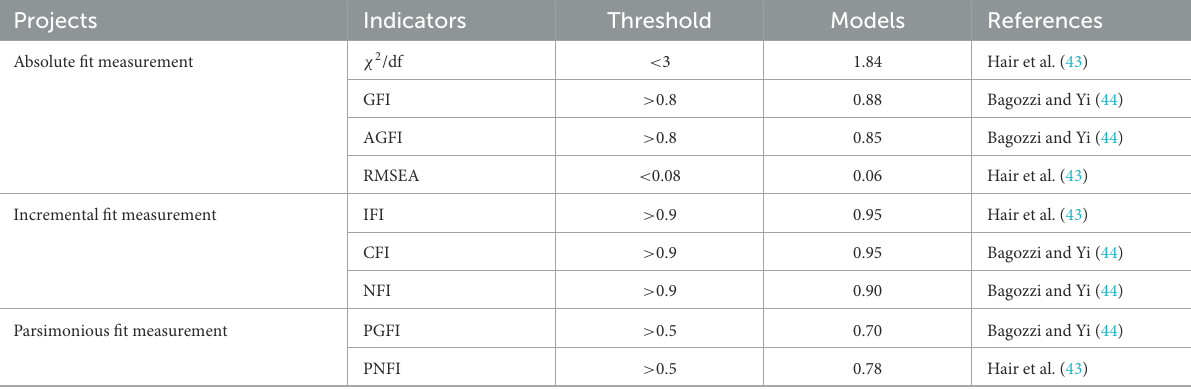
TABLE 4 Modified model fitness test values.